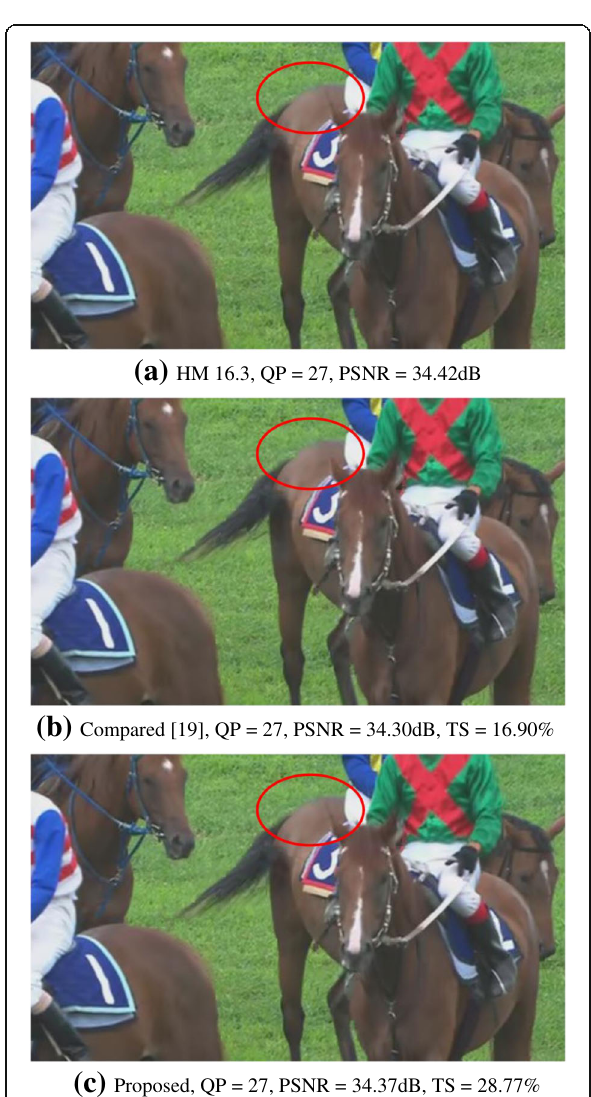
(c) Proposed, QP = 27, PSNR = 34.37dB, TS = 28.77% Fig. 20 Subjective comparison of S15 (RaceHores) under random- access configuration. ( a ) HM 16.3, QP = 27, PSNR = 34.42 dB. ( b ) Compared [19], QP = 27, PSNR = 34.30 dB, TS = 16.90%. ( c ) Proposed, QP = 27, PSNR = 34.37 dB, TS =